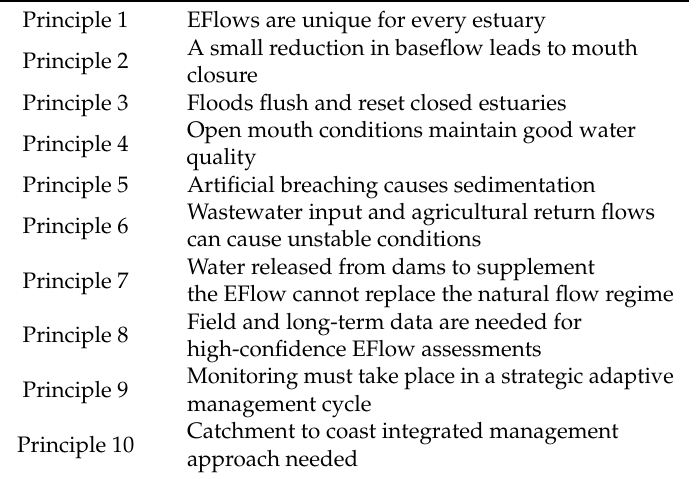
Table 6. Summary of the 10 principles to determine the EFlows for temporarily closed